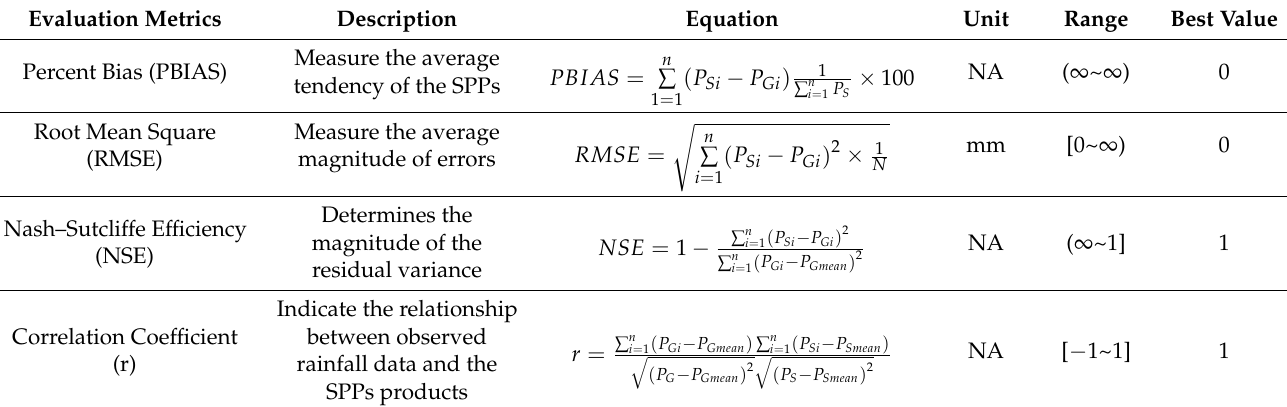
Table 2. List of the statistical metrics, used for the evaluation of satellite rainfall products. Evaluation